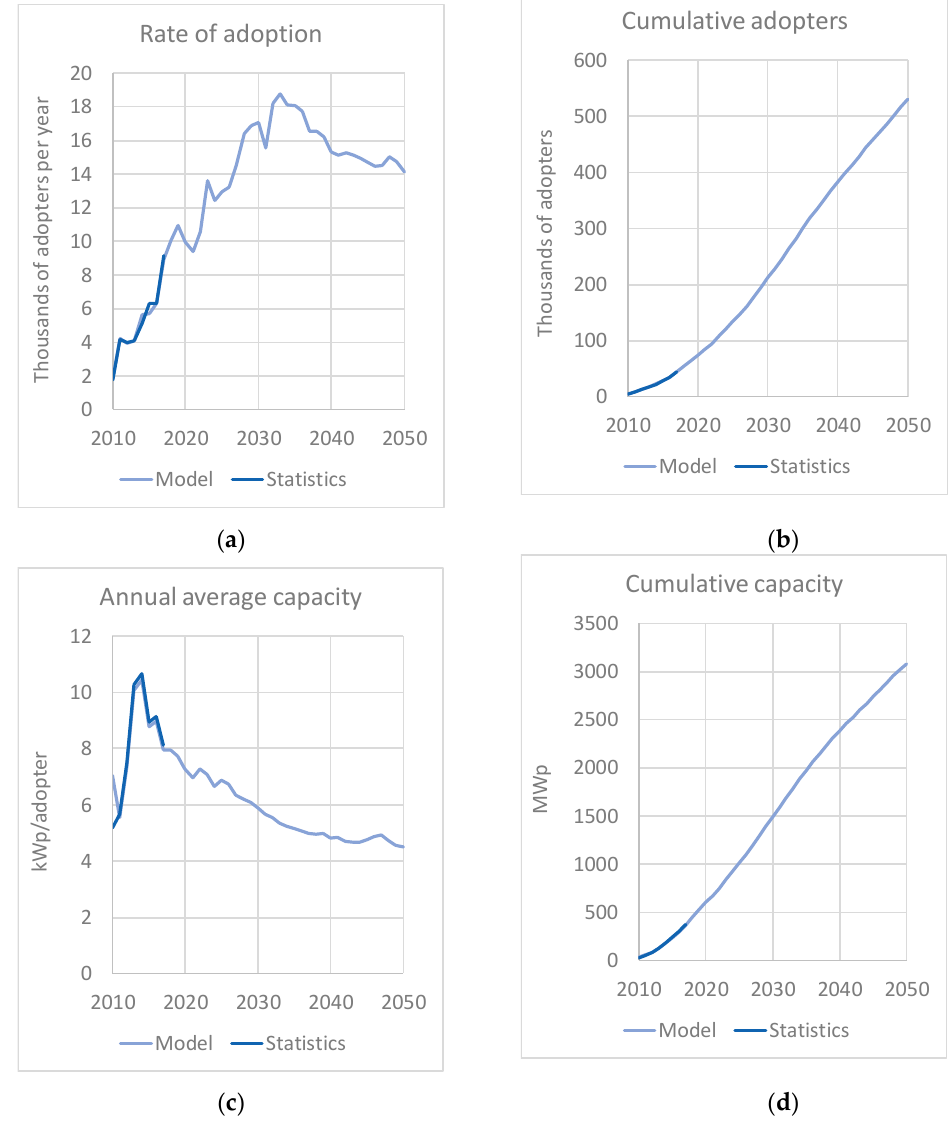
Figure 6. Annual rate of adoption (a), cumulative adopters (b), cumulative capacity (c) and average installed capacity per adopter (d) in the “Reference” scenario.